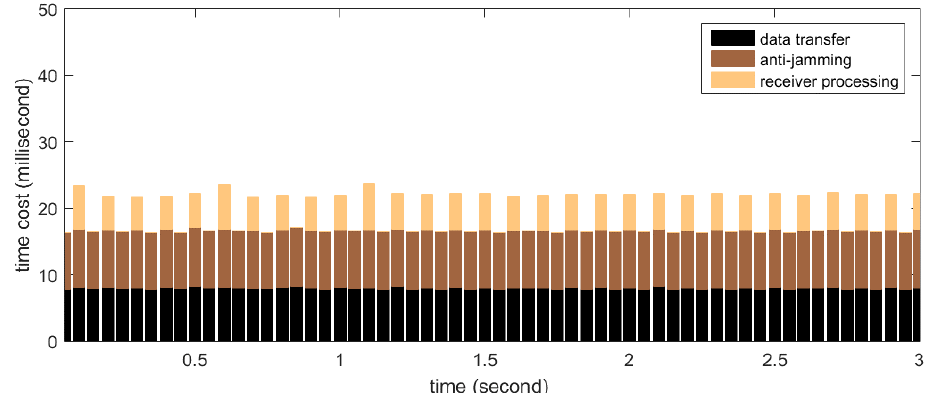
Figure 16. Time cost distribution for real-time processing with the space-frequency adaptive processor (SFAP).